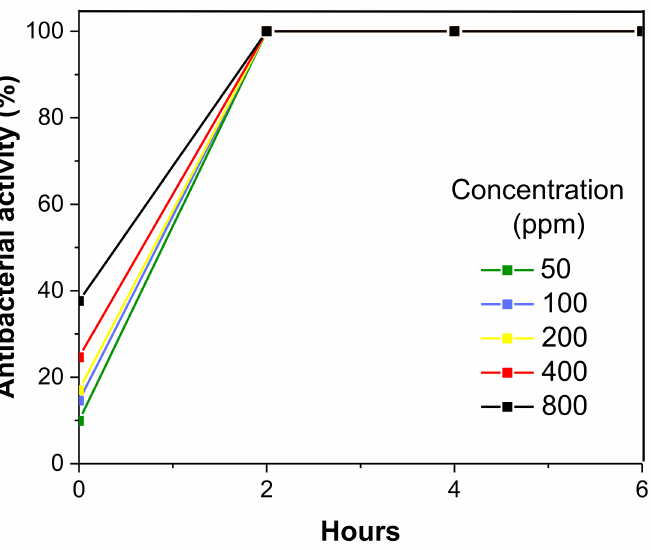
Figure 9. Percentage of the antibacterial activity of the Cu-PEI/AABT NPs against S. aureus at different